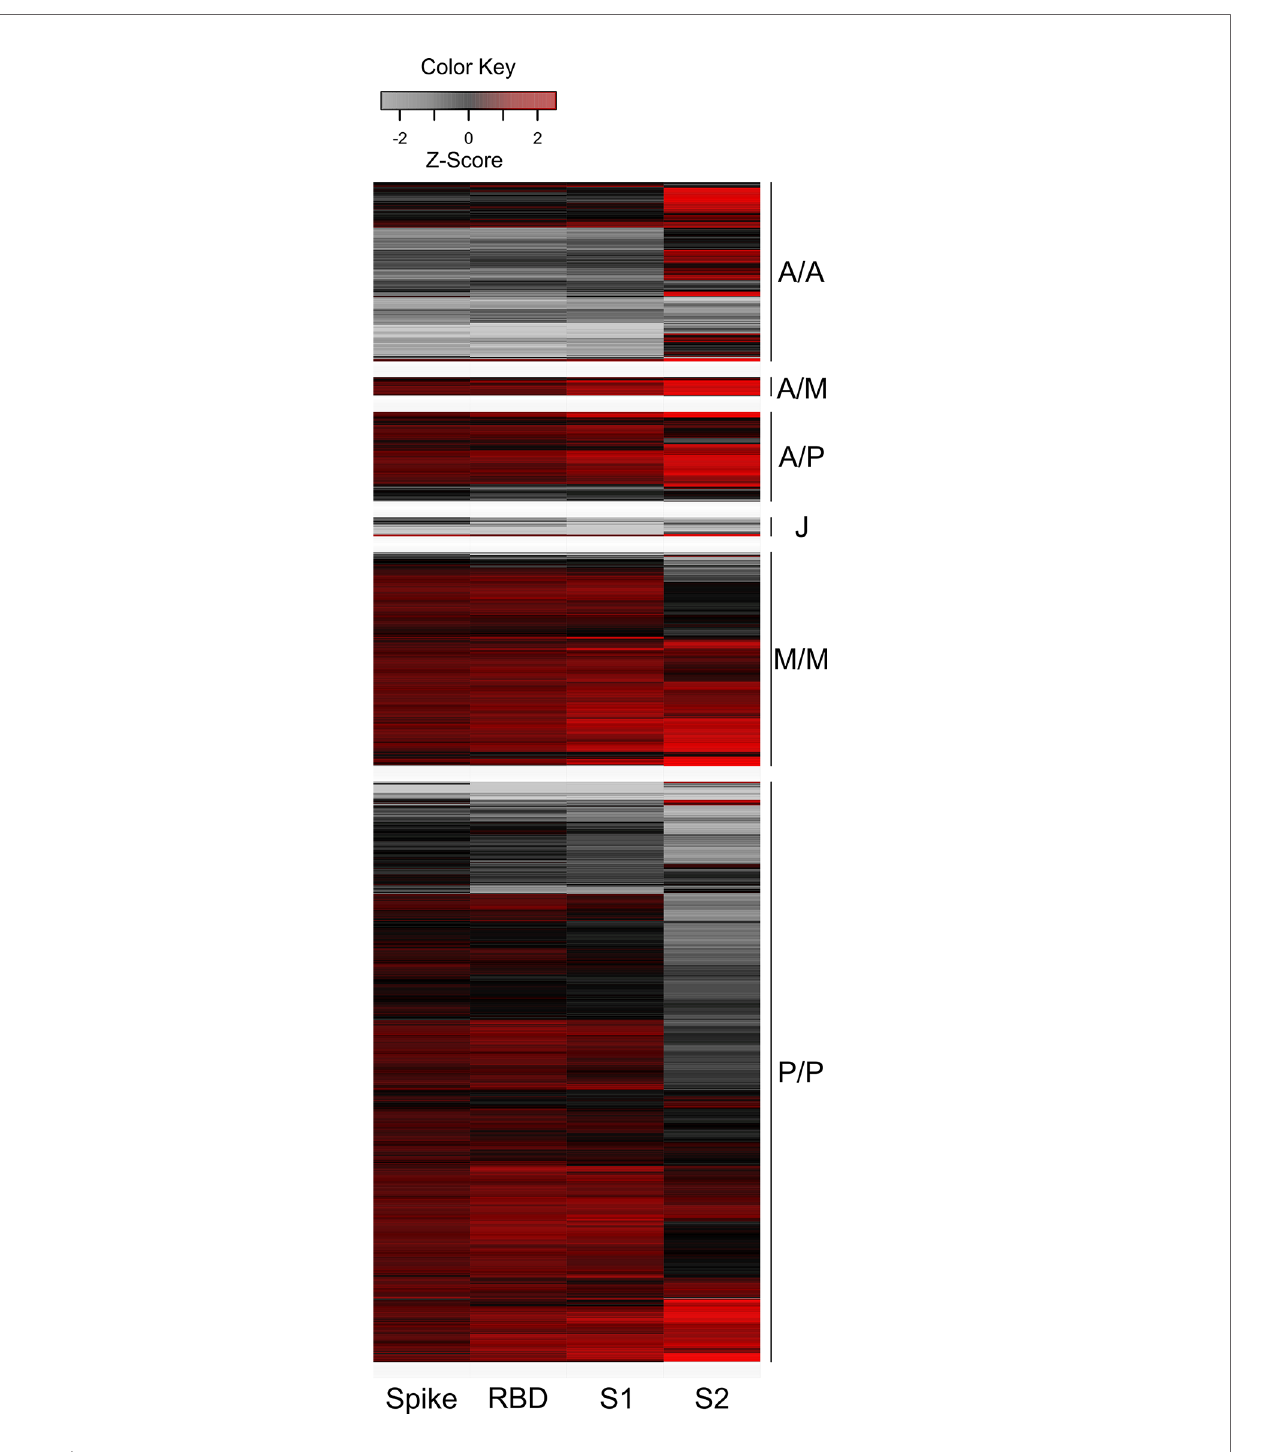
FIGURE 2 | Humoral immune response after mRNA vaccination is skewed towards increased RBD and S1 titres, while vector-based vaccination results in increased S2 antibody levels. Antigen-speci fi c antibody titres measured in the mix and match sample cohort were scaled and centered per antigen. Resulting values greater than 2.5 and smaller than -2.5 were set to these extreme values instead. Samples were then clustered within their subgroups based on immunisation scheme and are displayed as a heat map. Negative values represent below average titres and positive values represent positive above average titres per antigen. Colour shades indicate low (grey) to high (red) value distribution. A/A – two-dose AZD1222. A/M – fi rst dose AZD1222, second dose mRNA-1273. A/P – fi rst dose AZD1222, second dose BNT162b2. M/M – two-dose mRNA-1273. P/P – two-dose BNT162b2. J – one-dose